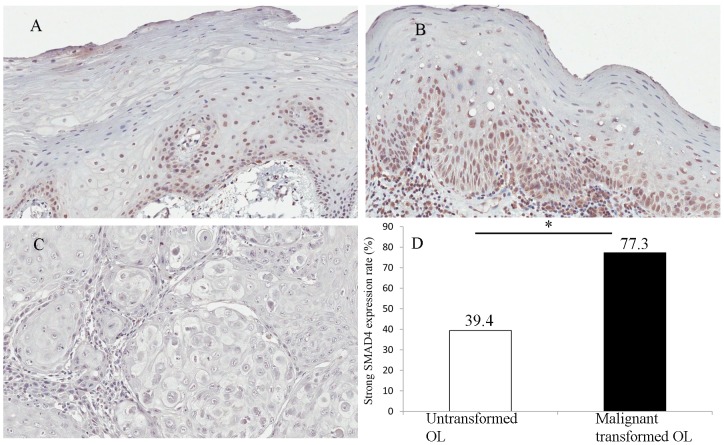
Expression pattern of SMAD4 in OL and OSCC samples.A, case 31: weak expression of SMAD4 in OL lesion which did not go through malignant transformation (x20). B, case 59:strong expression of SMAD4 in OL lesion which later went through malignant transformation (x20). C, OSCC samples which derived from OL lesion: weak expression of SMAD4 in OSCC samples. D, The frequency of strong SMAD4 expression is 39.4% in untransformed OL and 77.3% in malignant transformed OL. * indicated that p = 0.002.